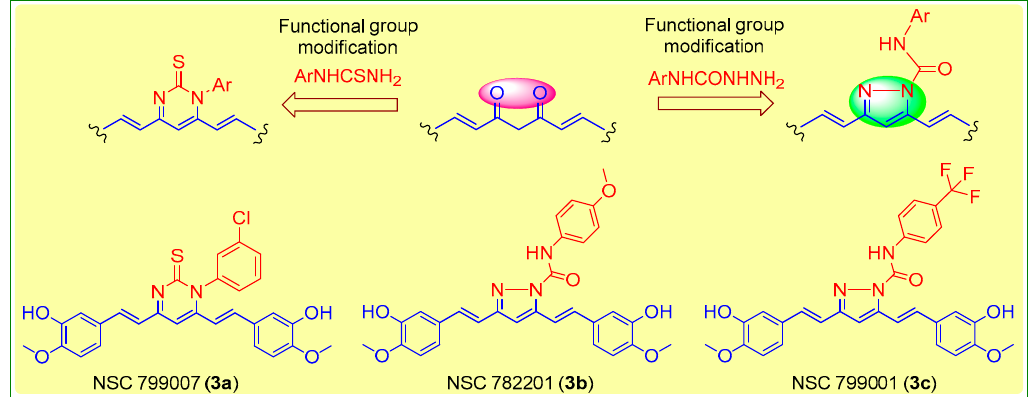
Figure 1. Molecular engineering of curcumin to pyrimidine thione ( 3a ), and pyrazoles ( 3b , c ) counterparts.